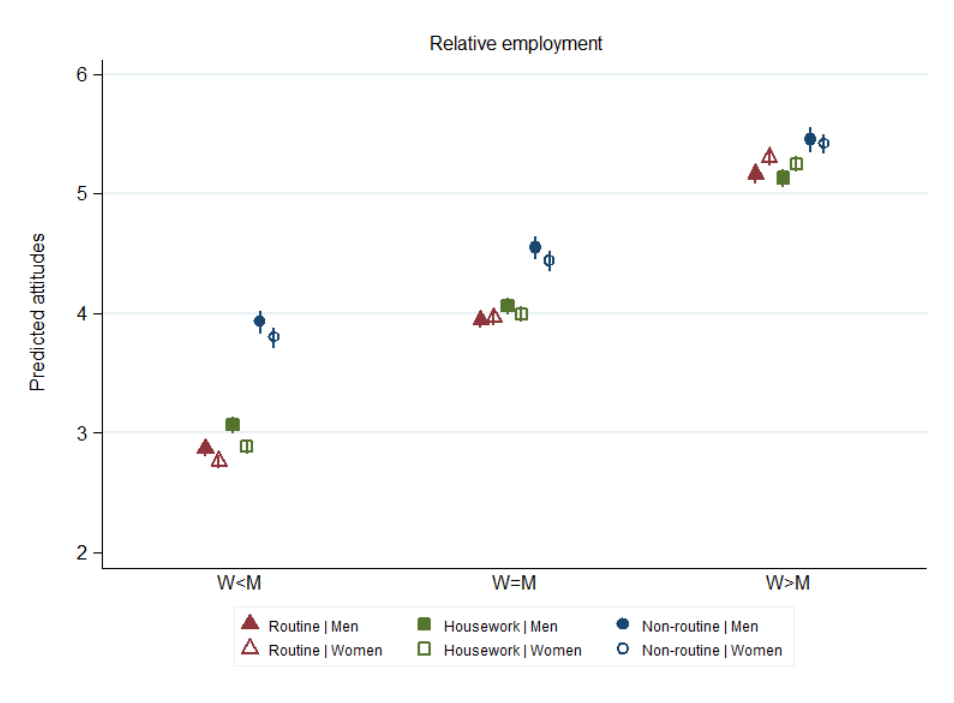
Figure 5 : Predicted attitudes towards housework by vignette couples’ relative